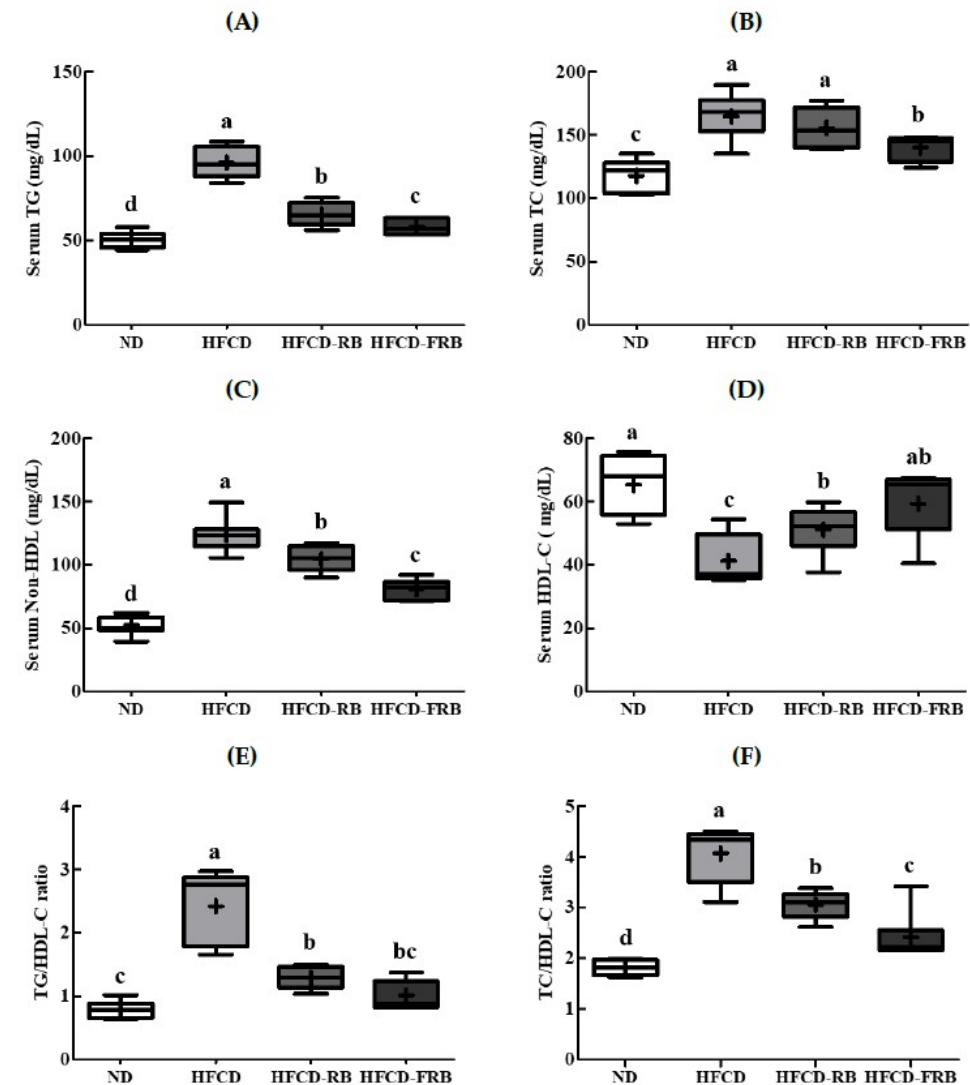
Figure 4. Lipid profiles, TG/HDL-C and TC/HDL-C ratios in mice fed experimental diets for 10 weeks. Diet groups: ND, normal diet group; HFCD, high-fat and -cholesterol diet group; HFD-RB, HFCD + non-fermented rice bran powder group; HFCD-FCA, HFCD + fermented rice bran powder group. Serum levels of ( A ) triglyceride (TG), ( B ) total cholesterol (TC), ( C ) non-high-density lipoprotein cholesterol (non-HDL-C), ( D ) high-density lipoprotein cholesterol (HDL-C), ( E ) TG/HDL-C and ( F ) TC/HDL-C ratios were measured in the experimental mice. Values are displayed as a Box-and-Whisker plot with means (expressed as ‘+’), n = 10. a-d: bars with different letters are significantly different at p < 0.05 by Tukey’s post hoc test.